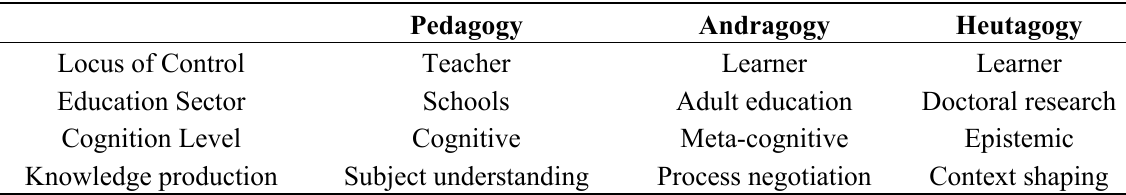
Table 1. The Pedagogy-Andragogy-Heutagogy (PAH) continuum ([19], p.